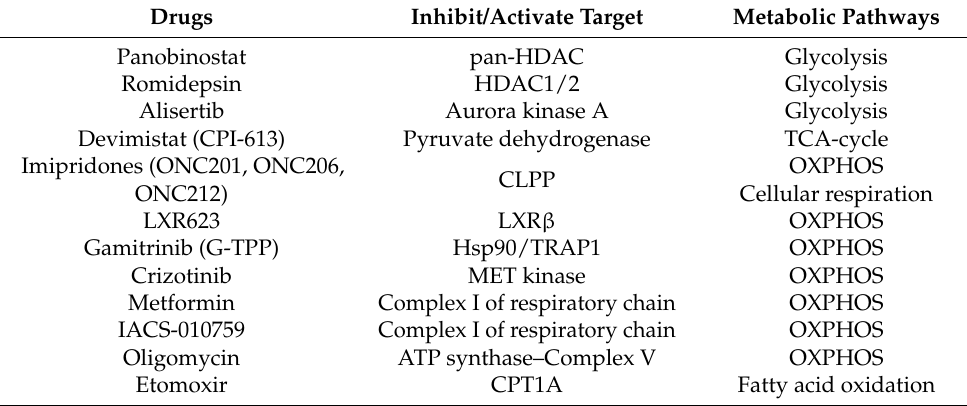
Table 1. A summary of therapeutic drugs with their specific inhibition/activation targets and the metabolic pathway affected by drug